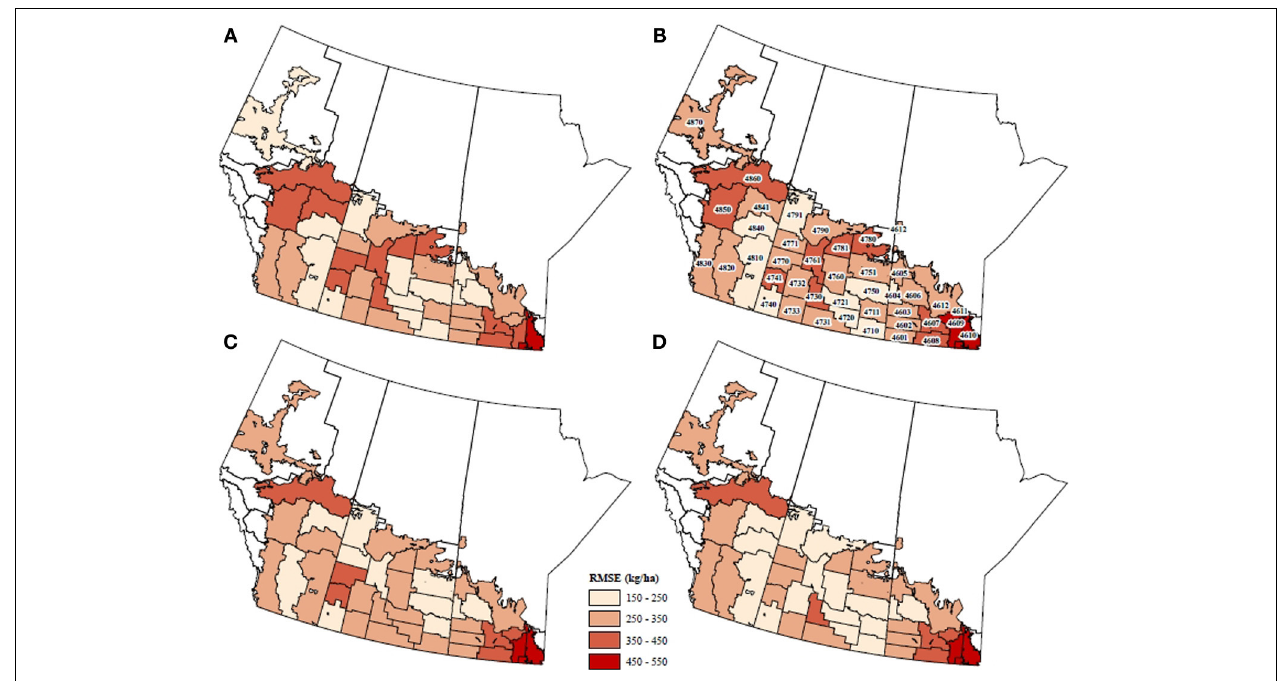
FIGURE 7 | Spatial maps of forecast error (RMSE) for different combinations of predictors. The predictors sets considered in each run were: (A) WDI, GDD, SWA, P, (B) WDI, GDD, and SWA (i.e., no P), (C)